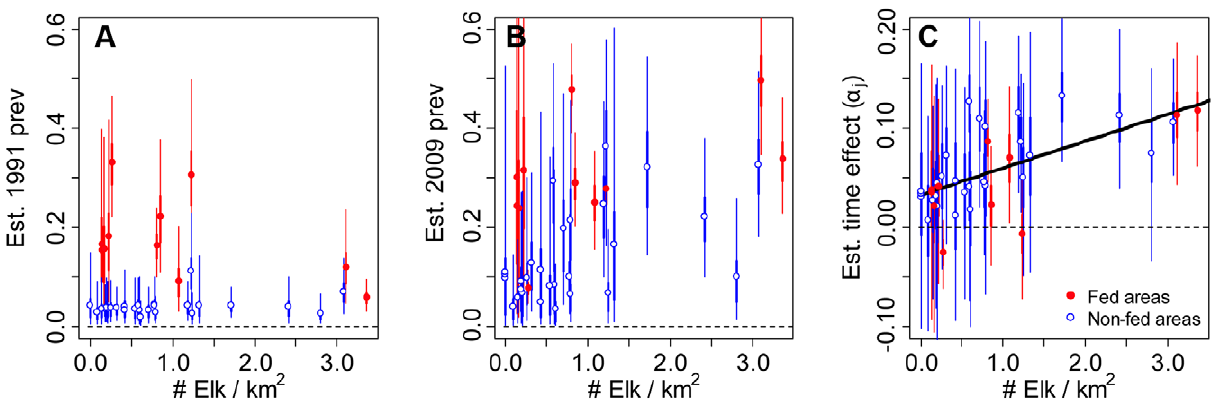
Figure 2. Model-based estimates of brucellosis seroprevalence among adult female elk as a function of elk density at the hunt area scale. The estimates for 1991 (A), 2009 (B) and the temporal trend (C) were based on the means of the predictive posterior distributions for Model 1 and were standardized by assuming all samples were from research captures. In (C), the temporal trend is on the logit scale, whereby , I . {lower case alpha} , sub . j , /sub ., /I . is the change in the log-odds of being test-positive in site , I . j , /I . associated with a one-year increase in time. The wide and thin lines refer to the 50 and 95% credibility intervals, respectively. Red solid circles represent regions that contained supplemental elk feeding grounds. Regions without feeding grounds are represented by blue open circles.